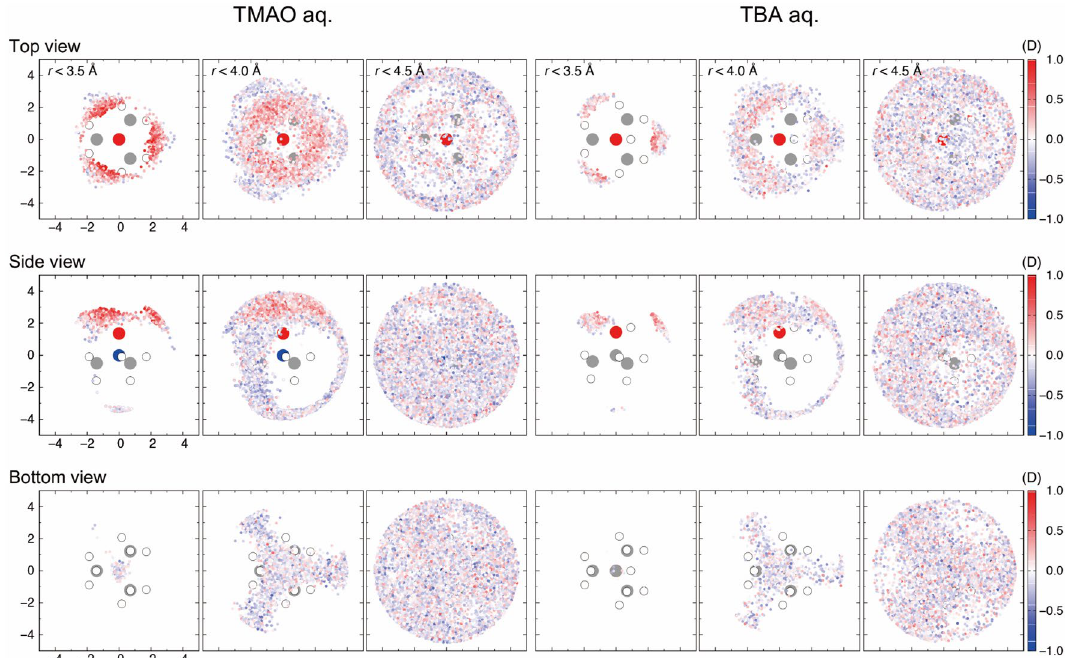
Figure 3. 1 ns water fluctuation colored by the dipole moments of H 2 O molecules. The water molecules within 3.5, 4.0, and 4.5 Å from the solute are observed from the top, side, and bottom. The plot color represents the deviation from the pure water (2.87